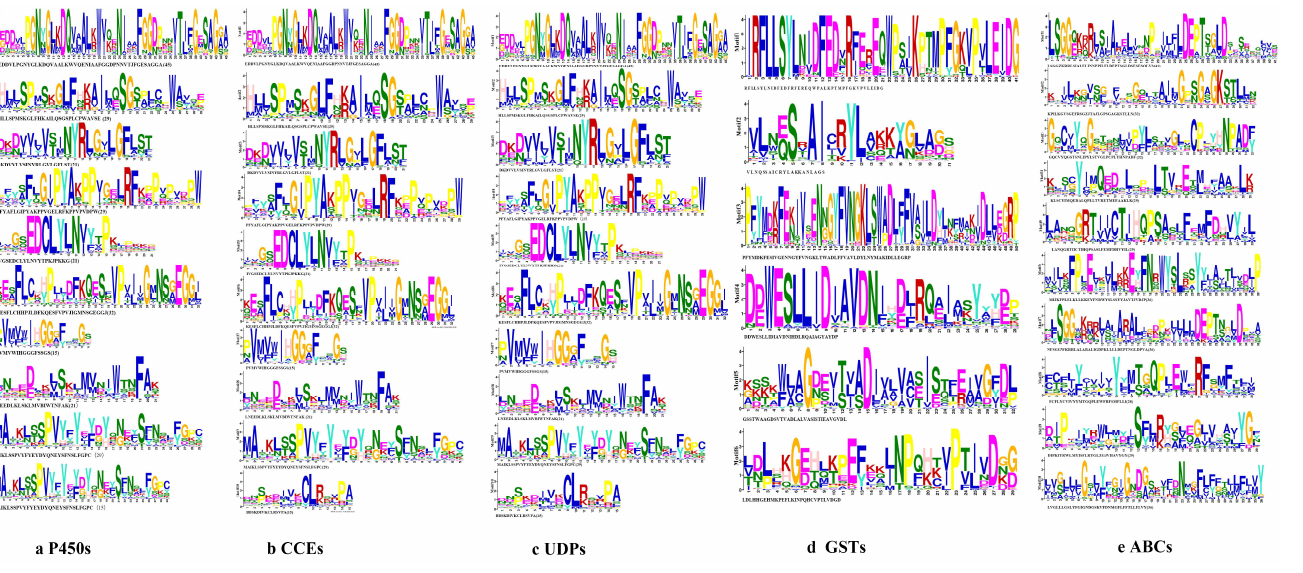
Figure 2. The 10 conserved motifs of detoxification genes families in the S. chinensis . ( a ) P450 gene family. ( b ) CCE gene family. ( c ) UDP gene family. ( d ) GST gene family. ( e ) ABC gene family.